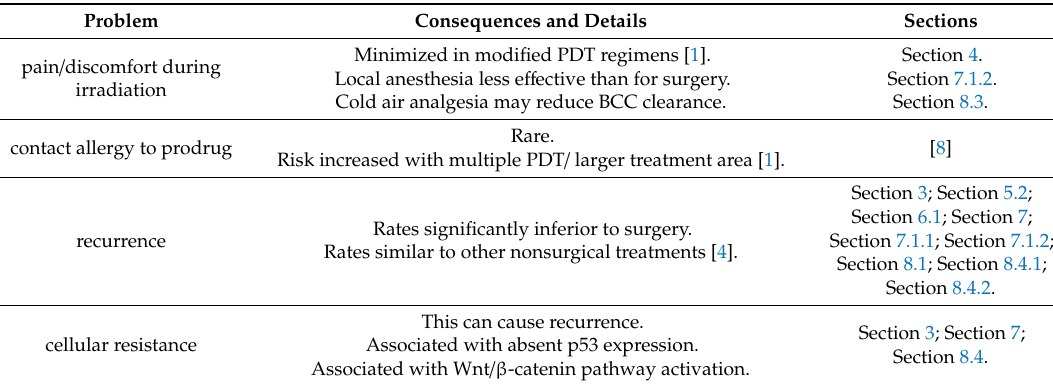
Table 3. Problems concerning adverse e ff ects, recurrence, and resistance in PDT for BCC.